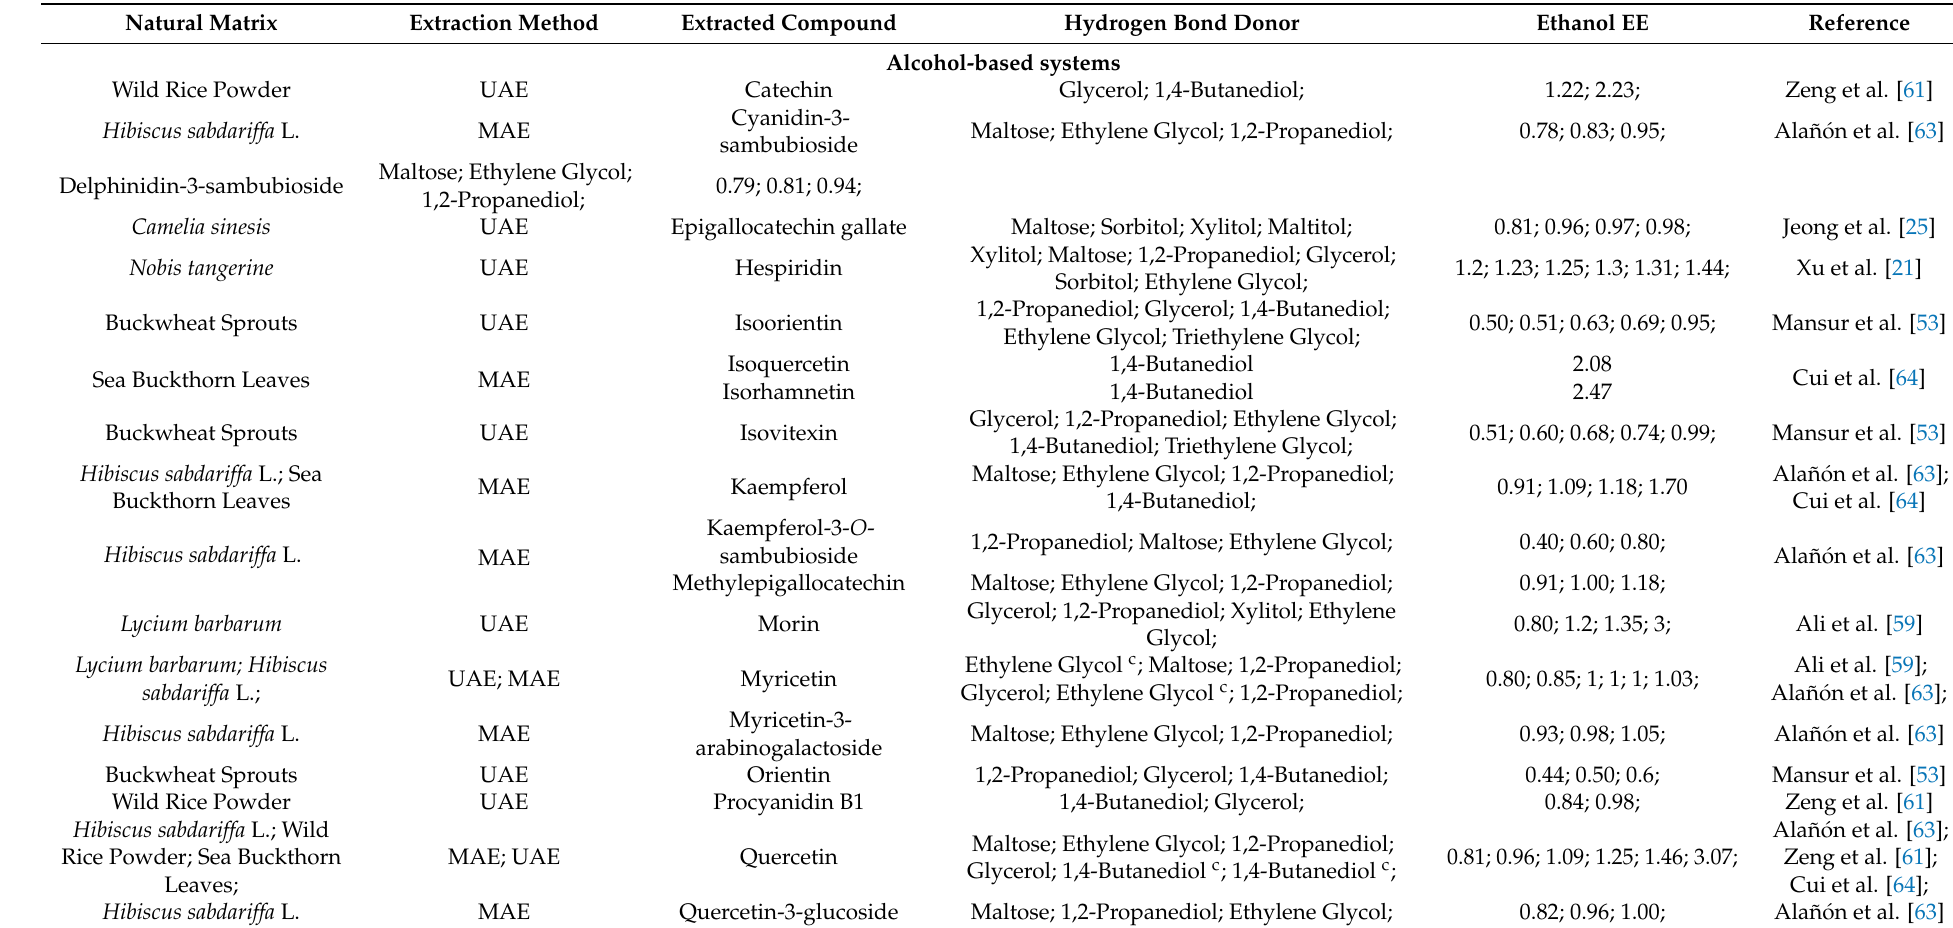
Table 2. Correlation between the natural matrix, extraction method, and DES based on ammonium salts (choline chloride and betaine) and the effect of different HBDs on the extraction efficiency of different flavonoids compared with ethanol